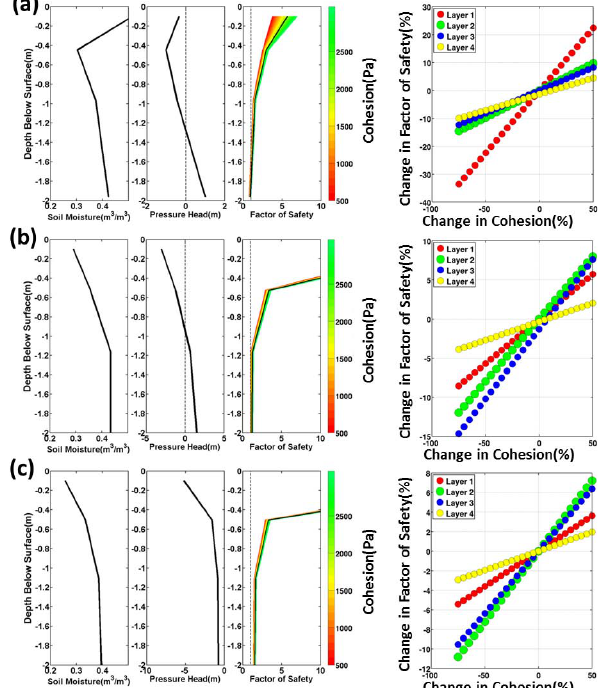
Fig. 16. Sensitivity analysis of the vertical profile of FS to soil in- ternal friction angle, for the slope failure cases in the BCB in July of 2011 (a) and JCB in January of 2009 (b) and December of 2009 (c) . The dark line is the actual failure case using the representative friction angle, 26 ◦ .